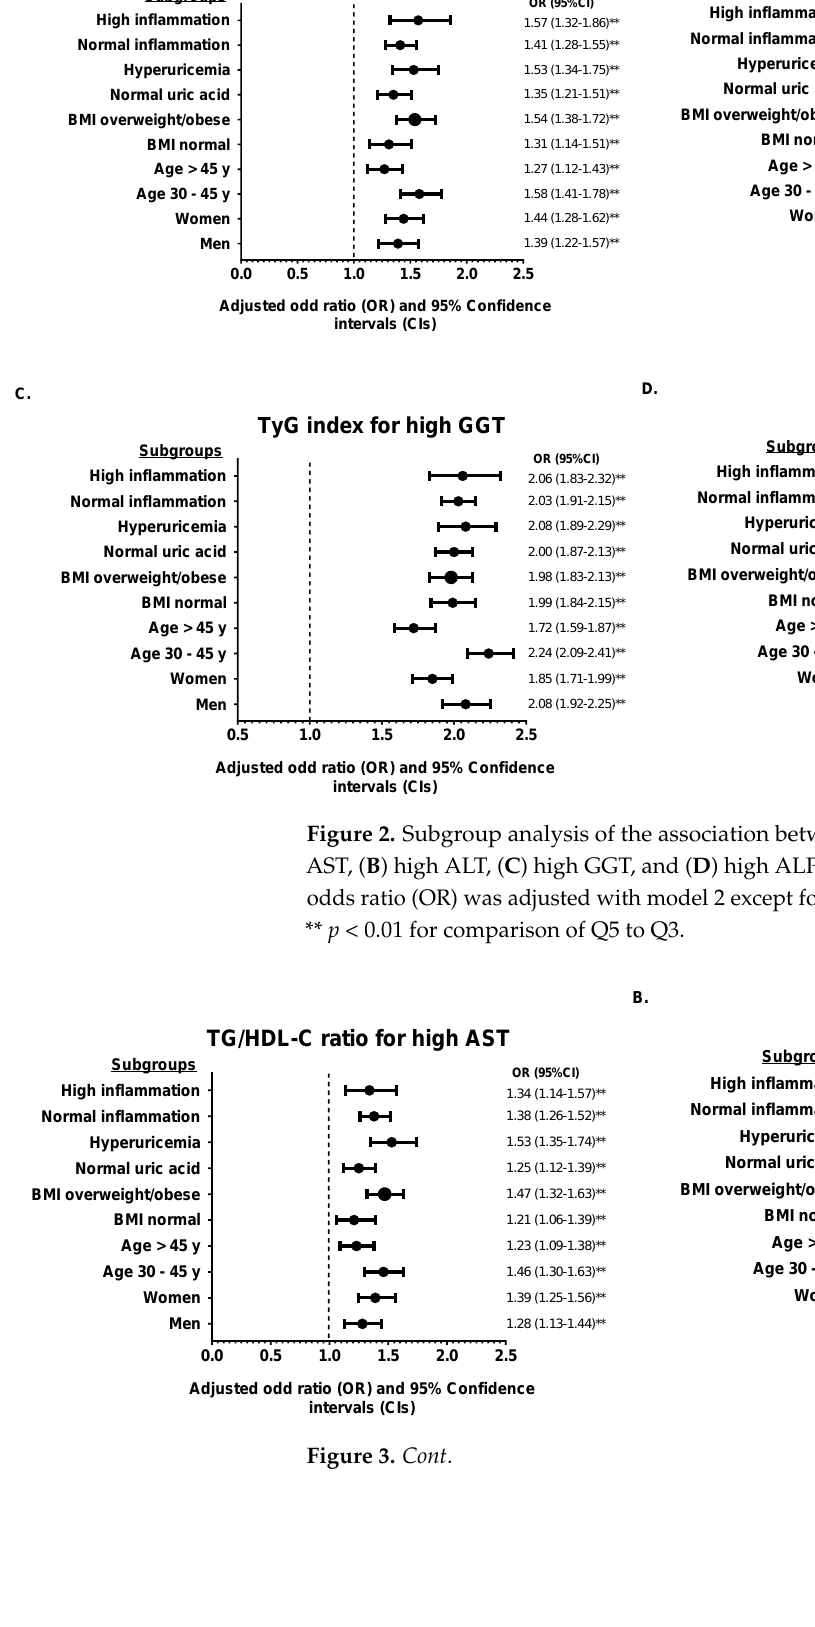
Figure 3. Subgroup analysis of the association between TG/HDL-C ratio in quintile 5 (Q4) with ( A ) high AST, ( B ) high ALT, ( C ) high GGT, and ( D ) high ALP. Quintile 3 (Q3) was used for the reference. The odds ratio (OR) was adjusted with model 2 except for stratified variables in each subgroup. ** p < 0.01 for comparison of Q5 to Q3. 4. Discussion Our data indicate that relatively new parameters, including the TyG index and the TG/HDL-C ratio as a surrogate of insulin resistance, might play a role in detecting abnor- mal liver function. We also demonstrated that a higher TyG index and TG/HDL-C ratio were positively associated with a higher risk of abnormal liver function after adjusting for potential confounders. We also analyzed the sensitivity and specificity of these two mark- ers. Thus, we observed a similar result for the TyG index and the TG/HDL-C ratio in terms of detecting abnormal liver function. Liver function is known to be related to insulin resistance and metabolic syndromes associated with elevated insulin, triglyceride, and glucose index [35]. A previous prospec- tive cohort study has shown the potential role of the TyG index in identifying non-alco- holic liver function disease (NAFLD) [34]. In the present study, a higher TyG index indi- cated a higher risk of liver abnormalities. Similar to a previous cross-sectional study con- ducted on 10,761 Chinese over 20 years of age, the number of NAFLD was significantly increased with the increasing levels of TyG (OR = 6.3, 95%CI: 5.3 – 7.5, p for trend < 0.0001)